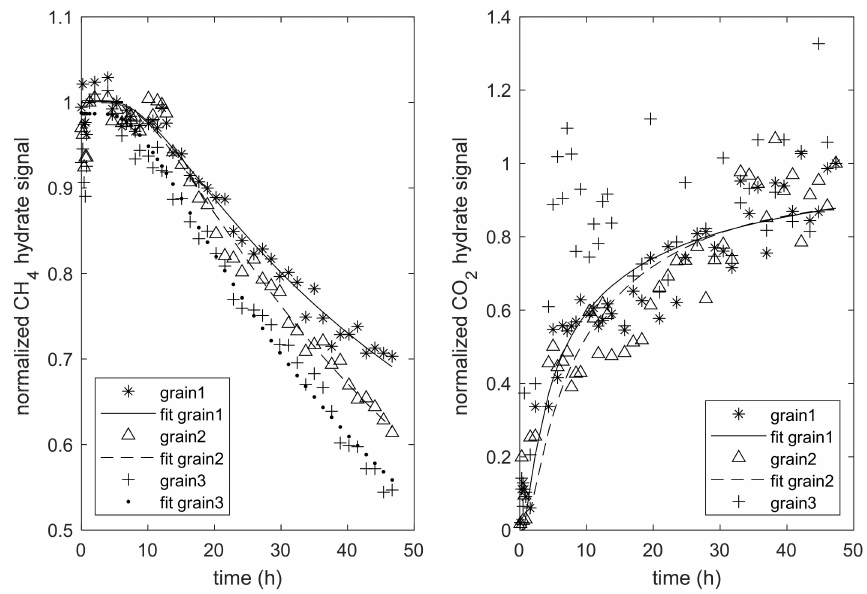
Figure 8. Time evolution of the CH 4 hydrate signal ( left ) and CO 2 hydrate signal ( right ) on grains 3, 4, and 5 with regressed